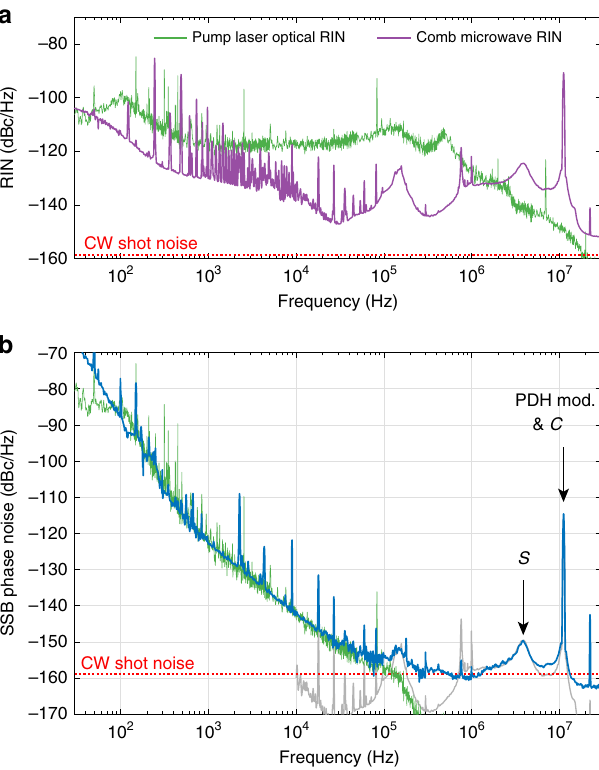
Fig. 6 Pump laser RIN and estimated limitation on the phase noise. a Optical RIN of the pump laser (green) and microwave amplitude noise of the soliton repetition rate (purple). b Phase noise spectrum of the repetition rate in the quiet point (blue) and estimated limitation from the pump laser RIN (green). The grey curve corresponds to the estimated AM-to-PM conversion in the photodiode (microwave amplitude noise scaled by −